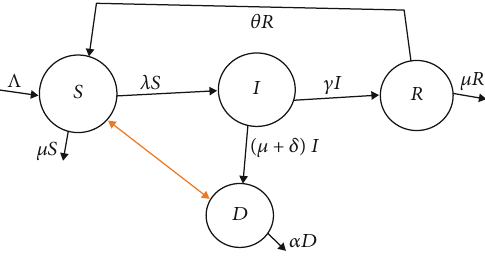
Figure 1: Flow chart of the Nipah